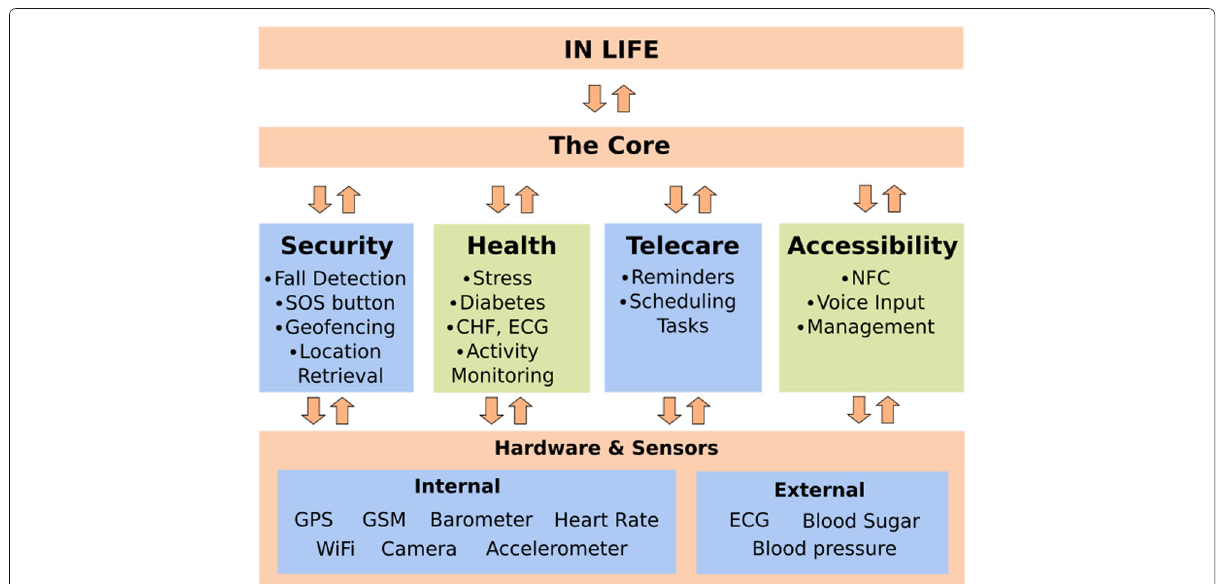
Fig. 1 Intelligent assistant carer (IAC). Bottom layer encompasses the hardware. Middle layer consists of independent modules (agents) that process the hardware input and output the results of their functions to the Core. The Core, based on the input from several sources, performs an action that is visible in the application IN